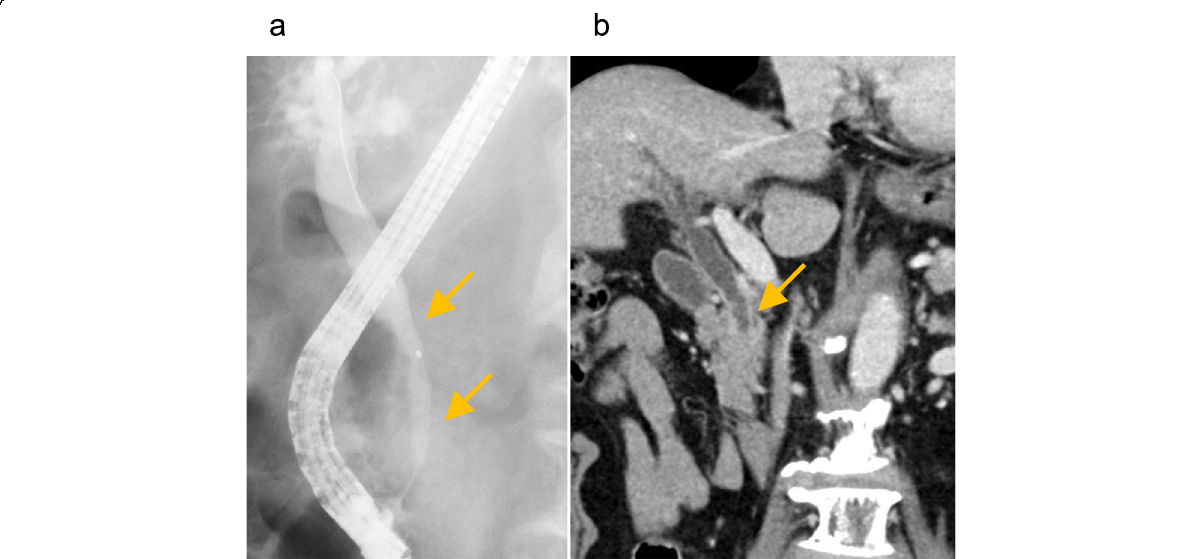
Fig. 1 Images of endoscopic retrograde cholangiography and MDCT of the distal bile duct. a Endoscopic retrograde cholangiography. Narrowing and wall-irregularity of the distal bile duct were found (arrow). b Abdominal MDCT. Wall thickness with contrast enhancement of the distal bile duct was identified (arrow). There was no invasion to the surrounding organs or vessels. MDCT, multi-detector computed tomography